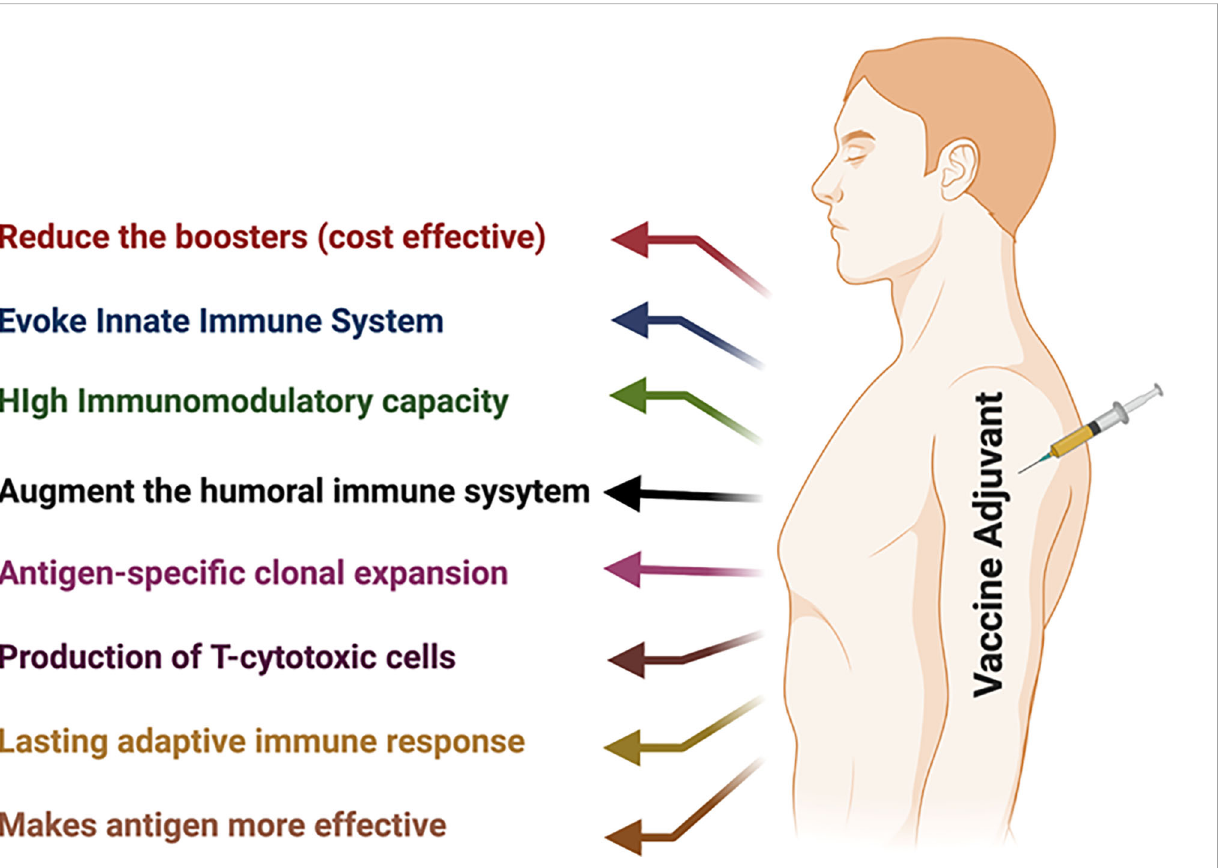
FIGURE 1 Schematic representation of vaccine adjuvants and their bene fi